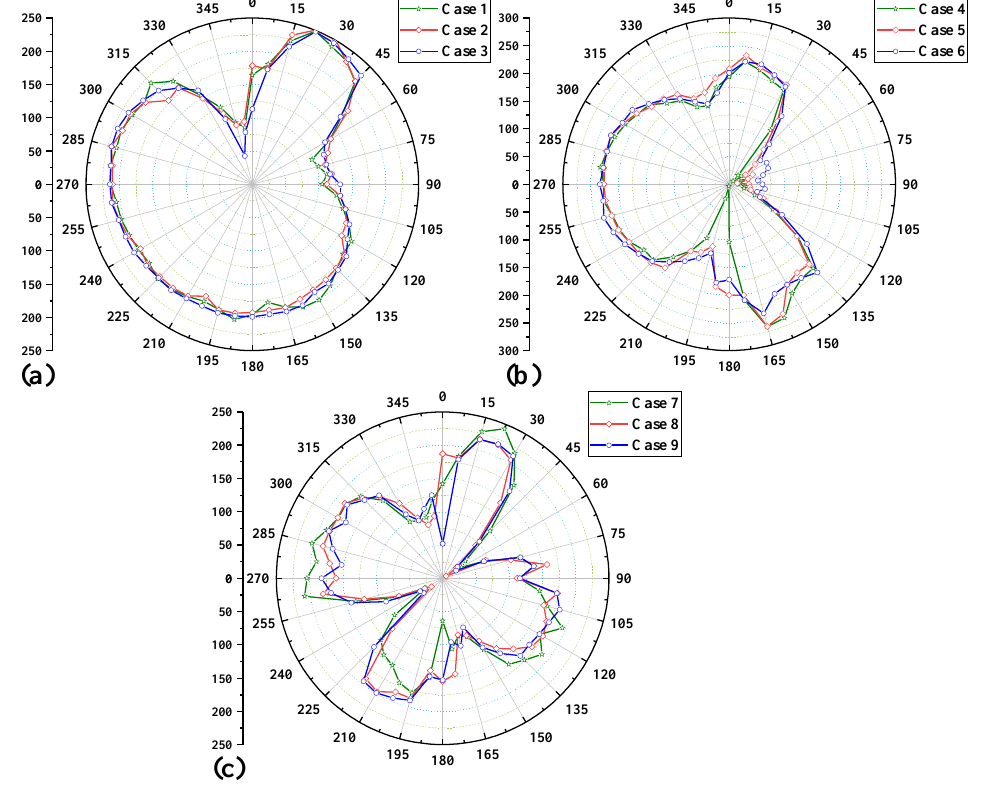
Figure 14. Axial residual stress distribution along path-4 for different welding cases. ( a ) Case 1 – 3 (welding sequence path-1) ( b ) Case 4 – 6 (welding sequence path-2) ( c ) Case 7 – 9 (welding sequence path-3).